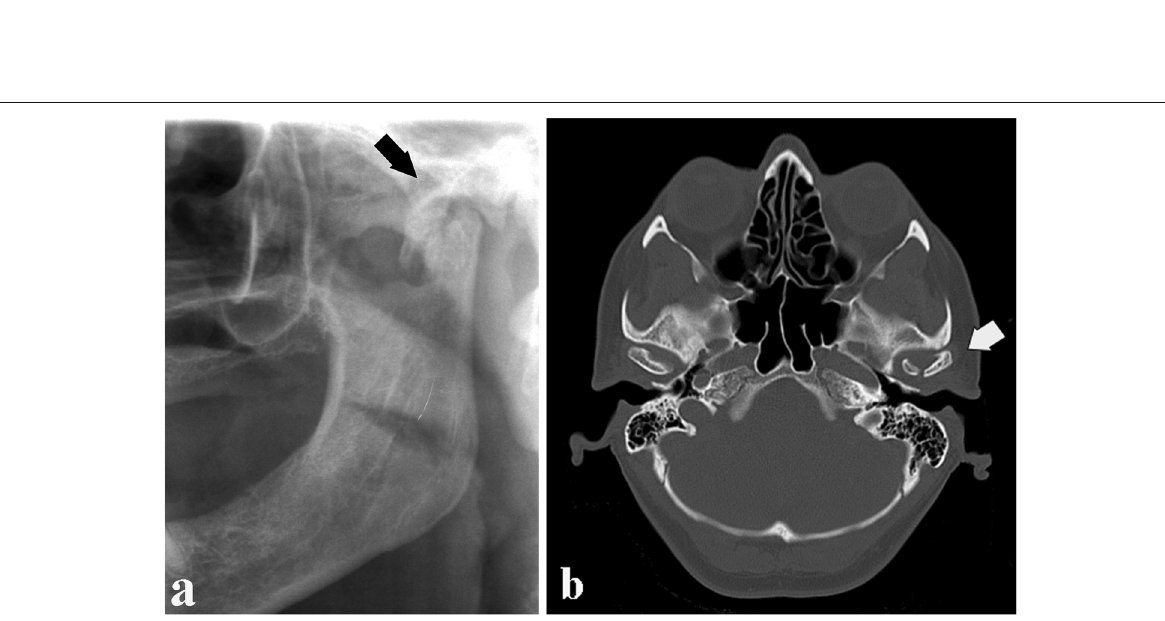
Fig. 20 Condylar head fracture. a Cropped panoramic radiograph. b Computed tomography axial section. Oblique fracture of the condylar head with involvement of the articular surface (intracapsular fracture)